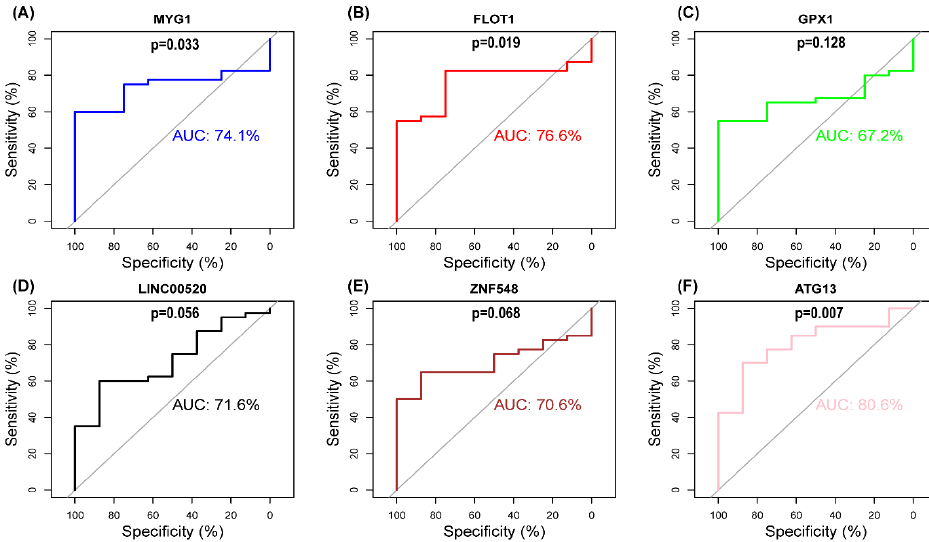
Figure 8. Receiver operating characteristic (ROC) curves of hub genes in GSE17800. ( A ) ROC curves of MYG1 . ( B ) ROC curves of FLOT1 . ( C ) ROC curves of GPX1 . ( D ) ROC curves of LINC00520 . ( E ) ROC curves of ZNF548 . ( F ) ROC curves of ATG13 . AUC >0.7 indicates good effect.